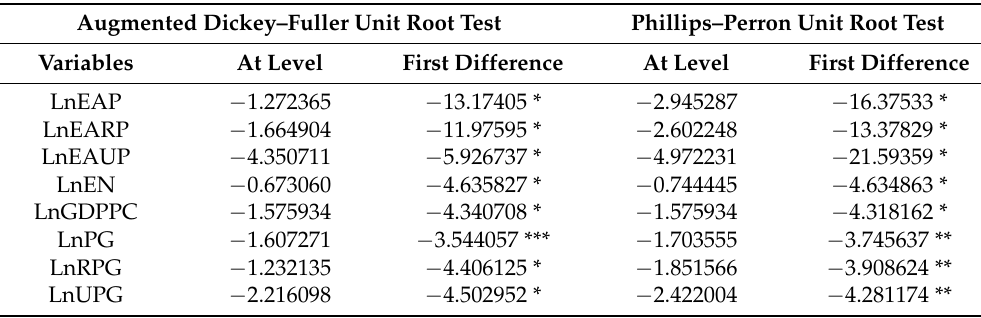
Table 2. Augmented Dickey–Fuller and Phillips–Perron Unit Root Test Results.